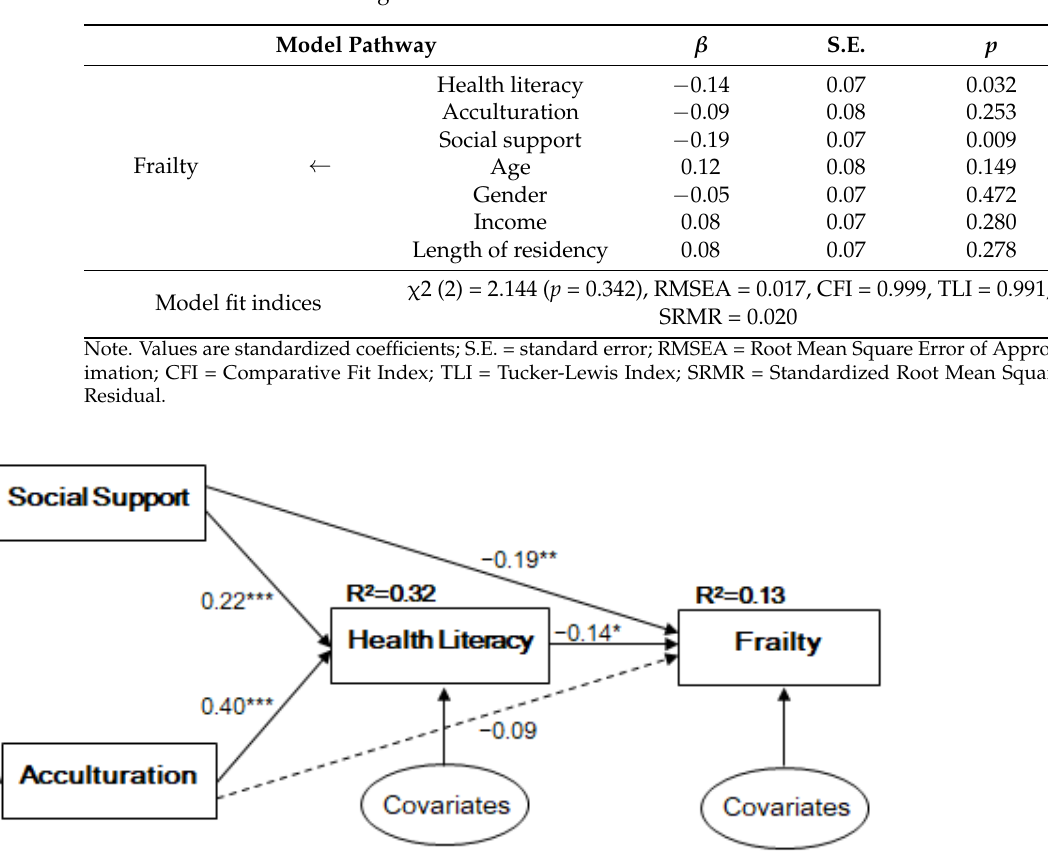
Table 3. Path estimates and significance of the model.